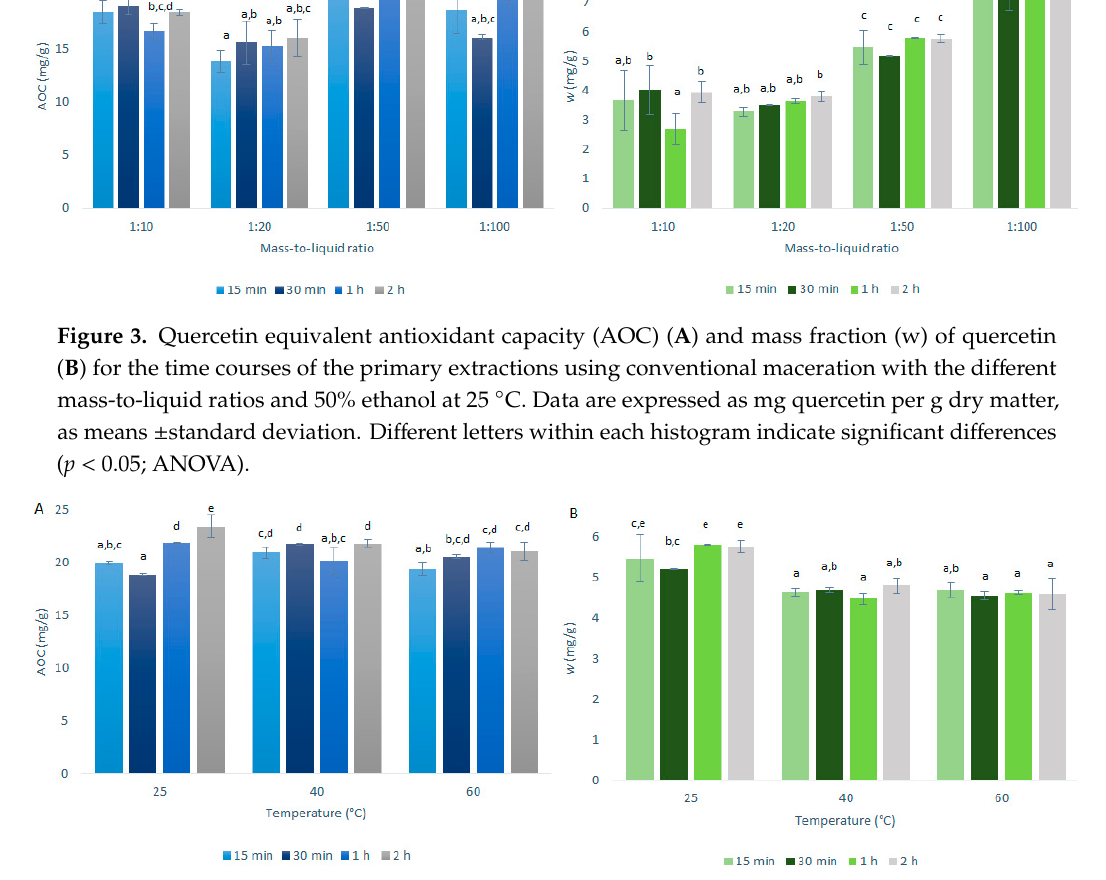
Figure 4. Quercetin equivalent antioxidant capacity (AOC) ( A ) and mass fraction (w) of quercetin ( B ) for the time courses of the primary extractions using conventional maceration with different temperatures and 50% ethanol and 1:50 mass-to-liquid ratio. Data are expressed in milligrams of quercetin per gram dry matter, as means ±standard deviation. Different letters within each histogram indicate significant differences ( p < 0.05; ANOVA).